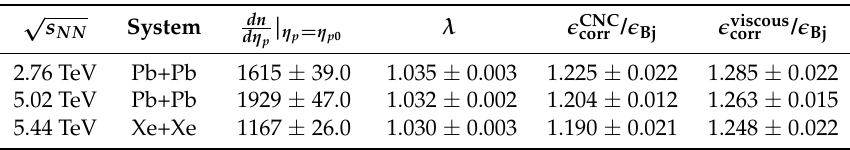
Table 1. Parameters from hydrodynamic results in the